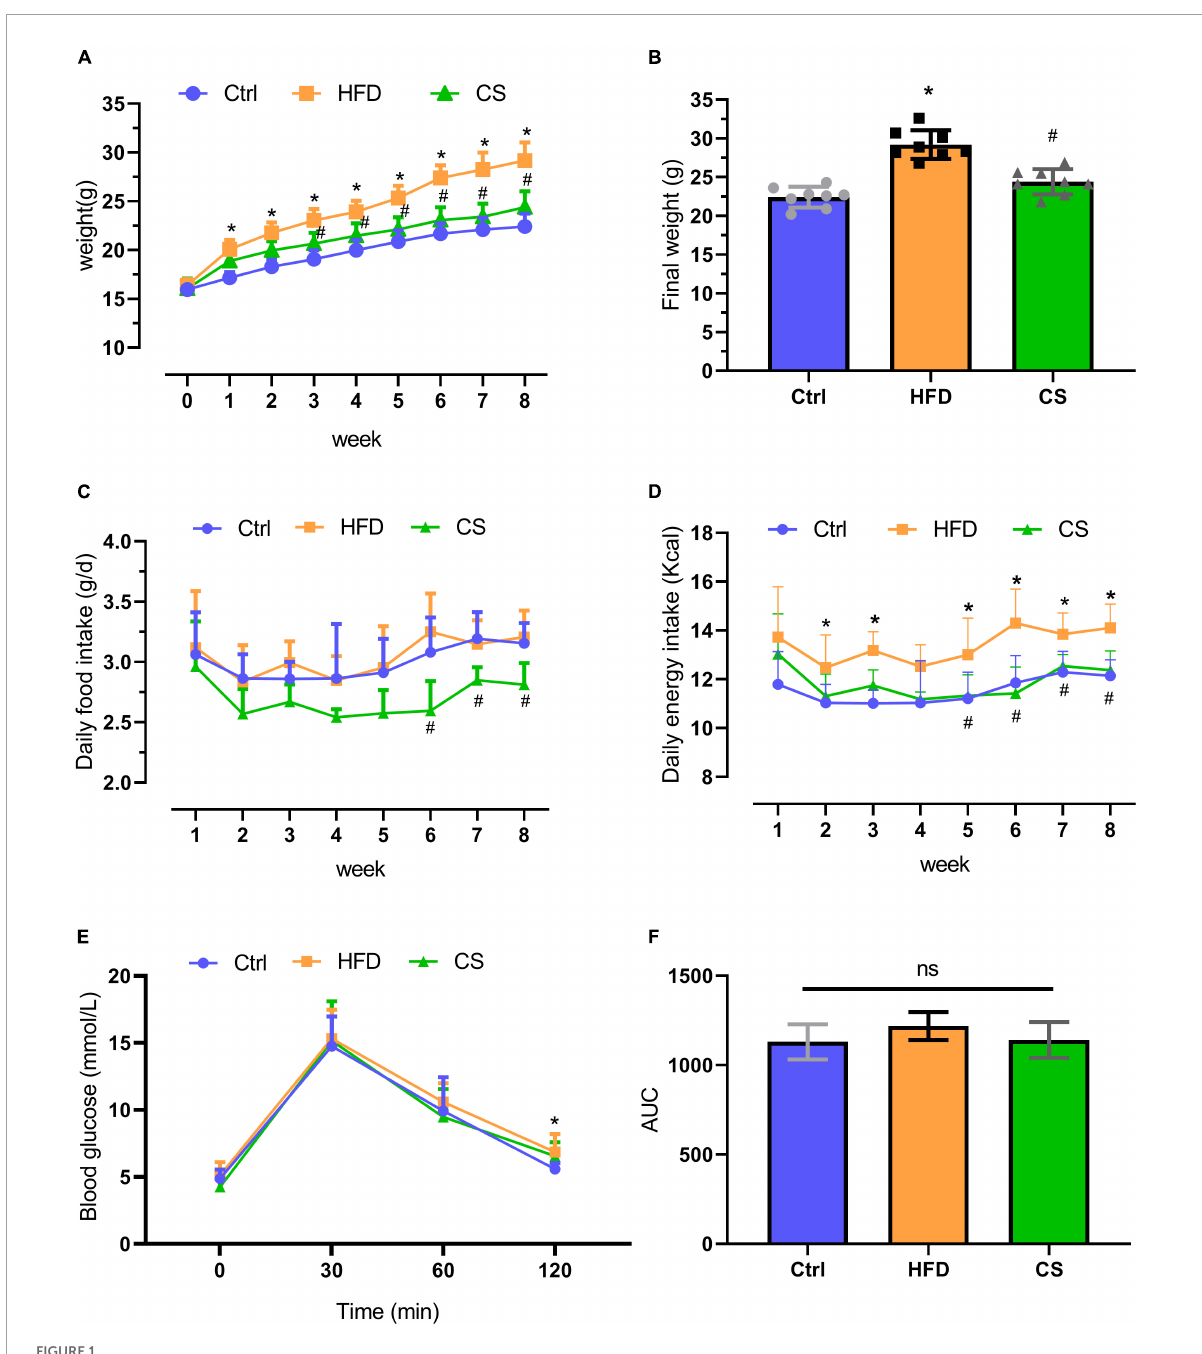
FIGURE1 Effect of corn silk extract on body weight and energy intake. (A) Body weight; (B) final weight; (C) daily food intake; (D) daily energy intake; (E) Glucose Tolerance Test; (F) area under the curve of the Glucose Tolerance Test. Control diet (Ctrl) group, high- fat diet (HFD) group, corn silk (CS) group. The results are means ± SD ( n = 8). * p < 0.05 vs. Ctrl, # p < 0.05 vs. HFD. ns, not